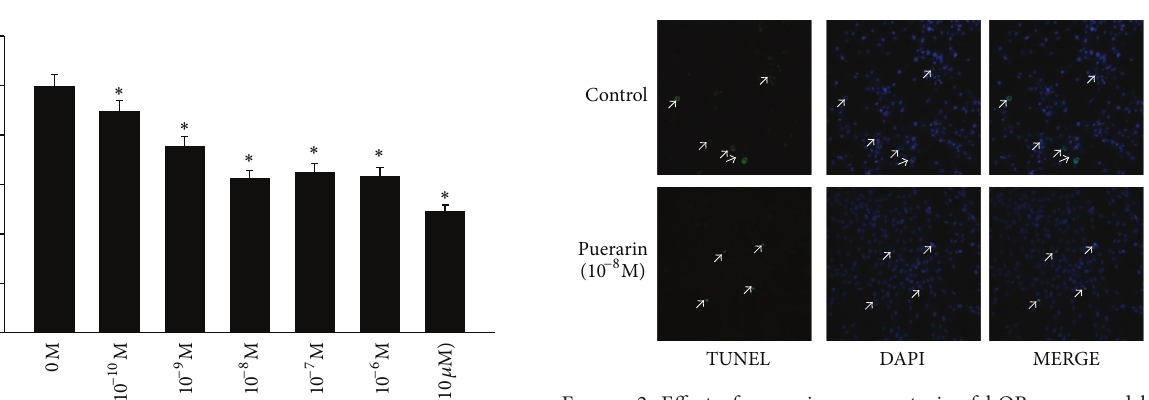
Figure 2: Effect of puerarin on apoptosis of hOBs measured by TUNEL assay. Cells were exposed to 10 −8 M puerarin for 48 h, while the control group was incubated with serum-free medium for 48h. Apoptotic nuclei were detected by TdT-mediated dUTP nick end-labeling (TUNEL). Arrows show apoptotic cells. Original magnification ×